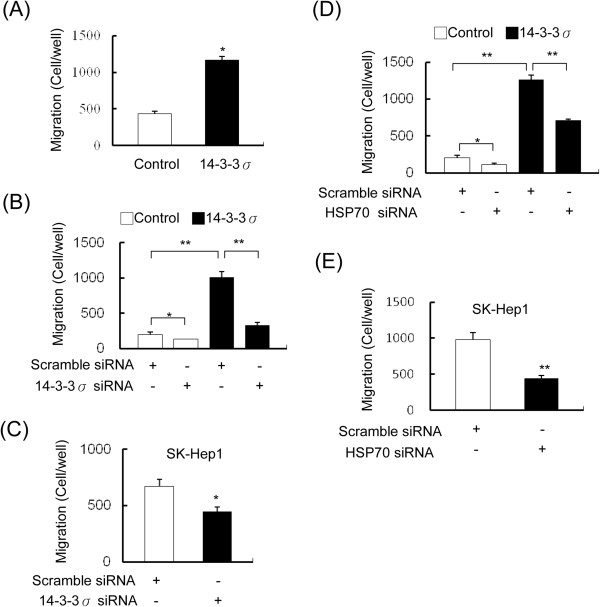
14-3-3σ induces cell migration via an increase of HSP70 expression. (A) Migratory ability of control and 14-3-3σ overexpressed Huh-7 cells was determined by a Boyden chamber assay. (B) Knockdown of 14-3-3σ with siRNA suppressed cell migration in 14-3-3σ stably overexpressed Huh-7 cells and (C) SK-Hep1 cells. (D) Knockdown of HSP70 with siRNA attenuated 14-3-3σ-induced cell migration in stable cells and (E) SK-Hep1 cells. Scale bars: mean ± SD. *P < 0.05, **P < 0.01.